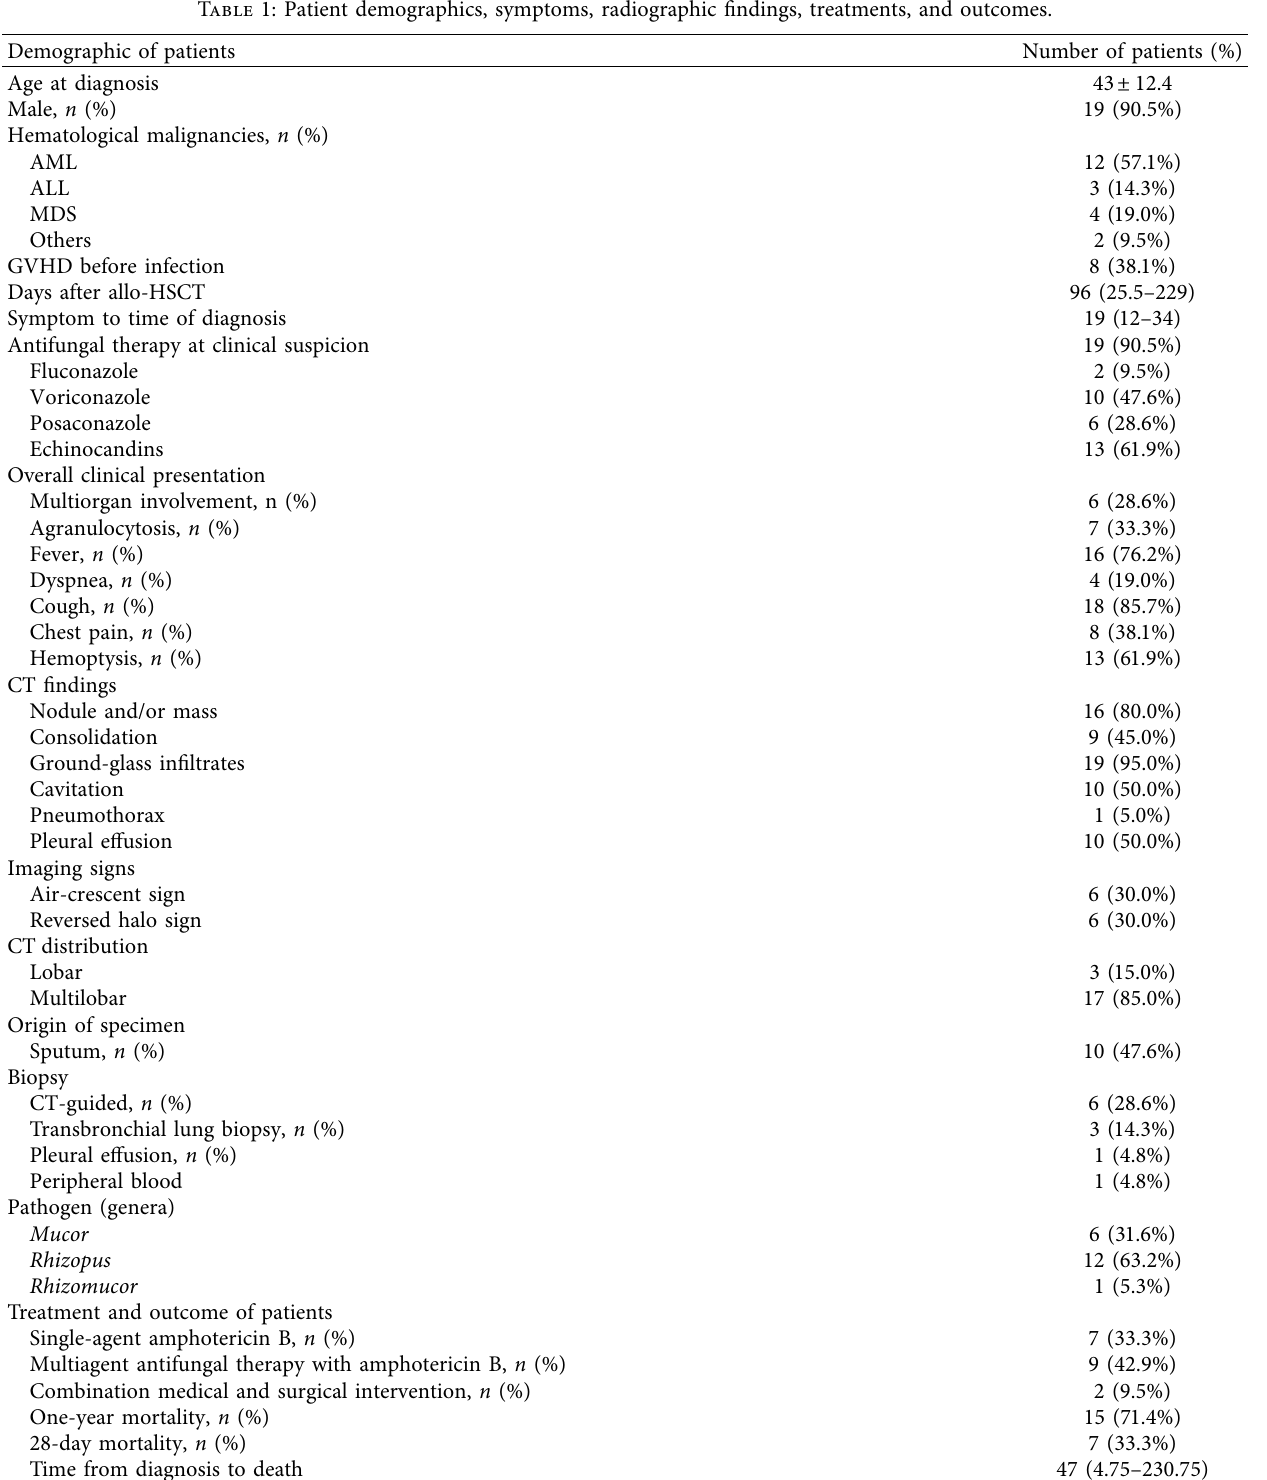
Table 1: Patient demographics, symptoms, radiographic findings, treatments, and outcomes. Demographic of